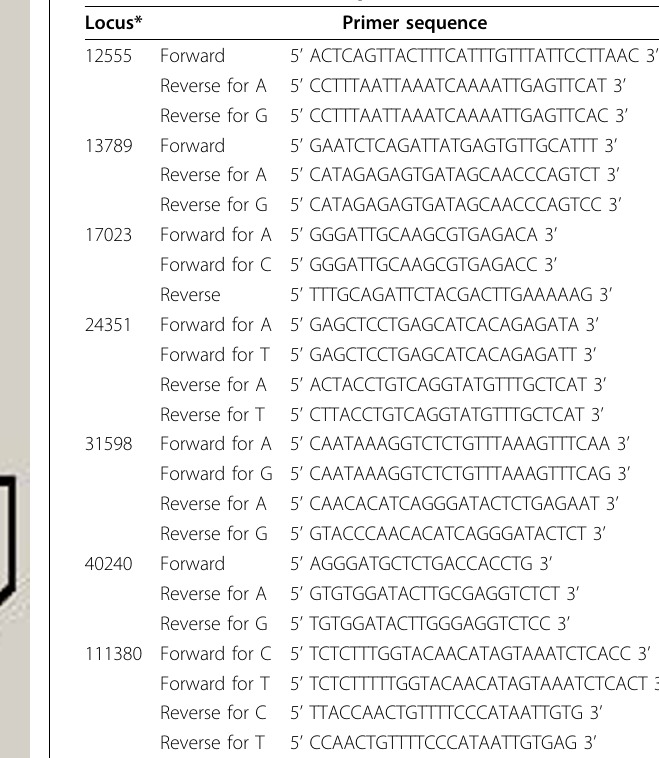
Table 1 Primers for allele specific PCR